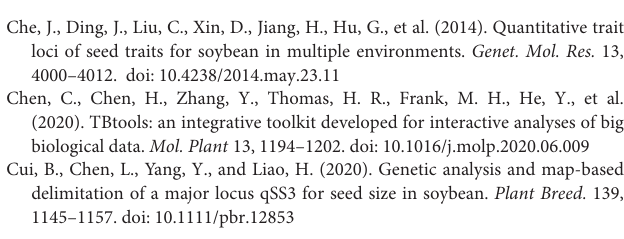
Supplementary Table 9 | Predictive candidate genes in qSS2